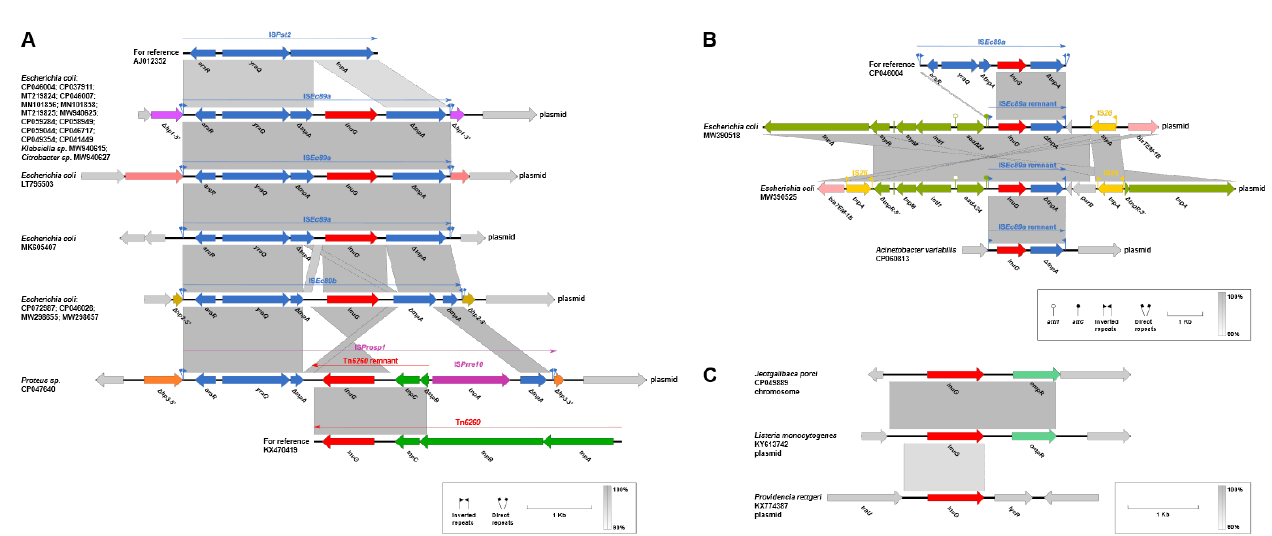
Figure 7. The genetic contexts of lnu(G) from other plasmids and chromosomes. IS Pst2 -associated genetic contexts of lnu(G) , type D1 and type D2, are shown in ( A ) and ( B ), respectively. The lnu(G) genetic contexts of type E is shown in ( C ). The lnu(G) was indicated in red. Genes are colored based on their functional classification. Gray shading denotes genetic regions that exhibit sequence homology among different segments. Δ represents truncated genes or mobile genetic elements.